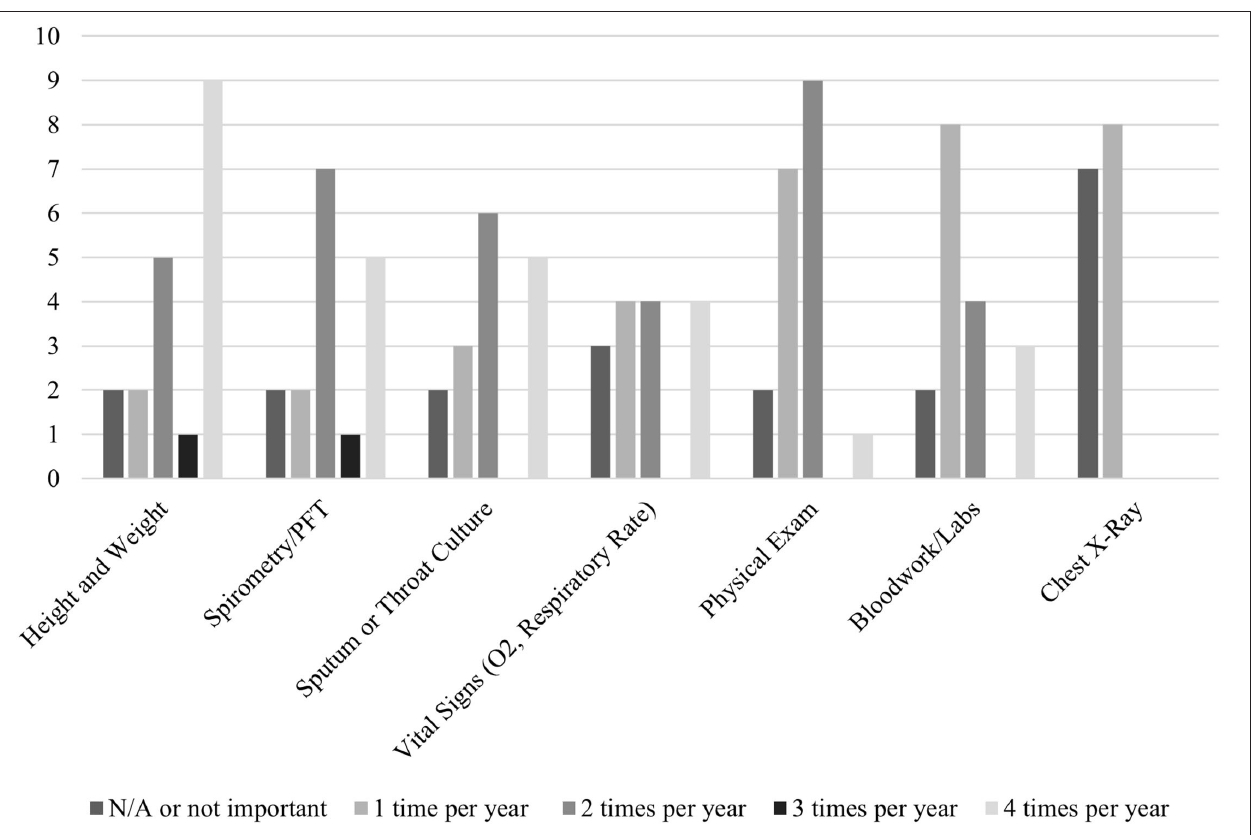
FIGURE 3 | Frequency of obtaining clinical data as desired by